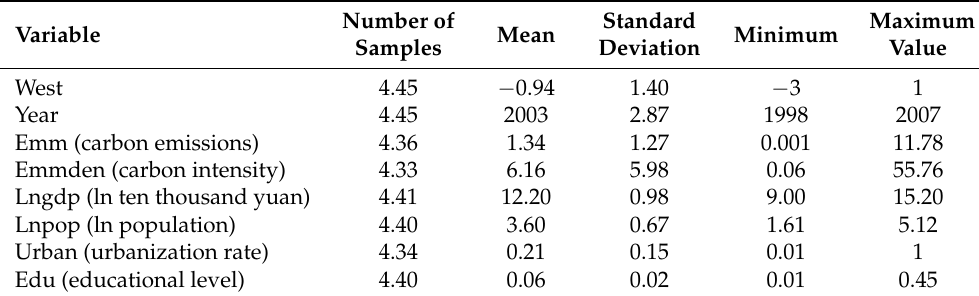
Table 1. Descriptive statistics of main